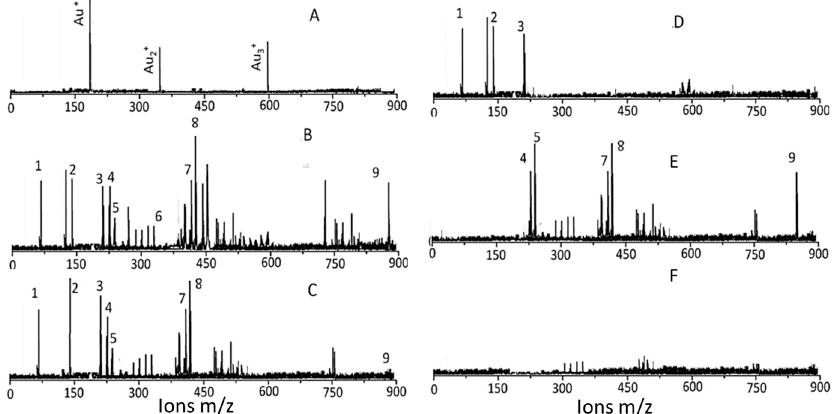
Figure 4. Mass spectral identification of surface ligands. ( A ) L MALDI that detects Au ions; ( B ) typical LDI (matric free) analysis of AuNP KG-50 synthesized by a mixture of kudzu root and gum; ( C ) typical LDI analysis of a mixture of kudzu and gum solutions; ( D ) typical LDI (matrix free) analysis of AuNP G-50 synthesized by a gum solution alone; ( E ) typical LDI (matrix free) analysis of AuNP K-50 synthesized by a kudzu extract alone; and ( F ) analysis of a blank solution. Peak identification 1: 73 m / z arabinose, galactose, fructose; 2: 147 m / z galactose; 3: 217 arabinose; 4: 225 m / z daidzein; 5: 229 m / z d4-daidzein; 6: 370 m / z not identified; 7: 417 m / z puerarin, 8: 429 not identified; 9: 894 kakkasaponin; Au + 193 m / z ; Au 3+ 396 m / z .